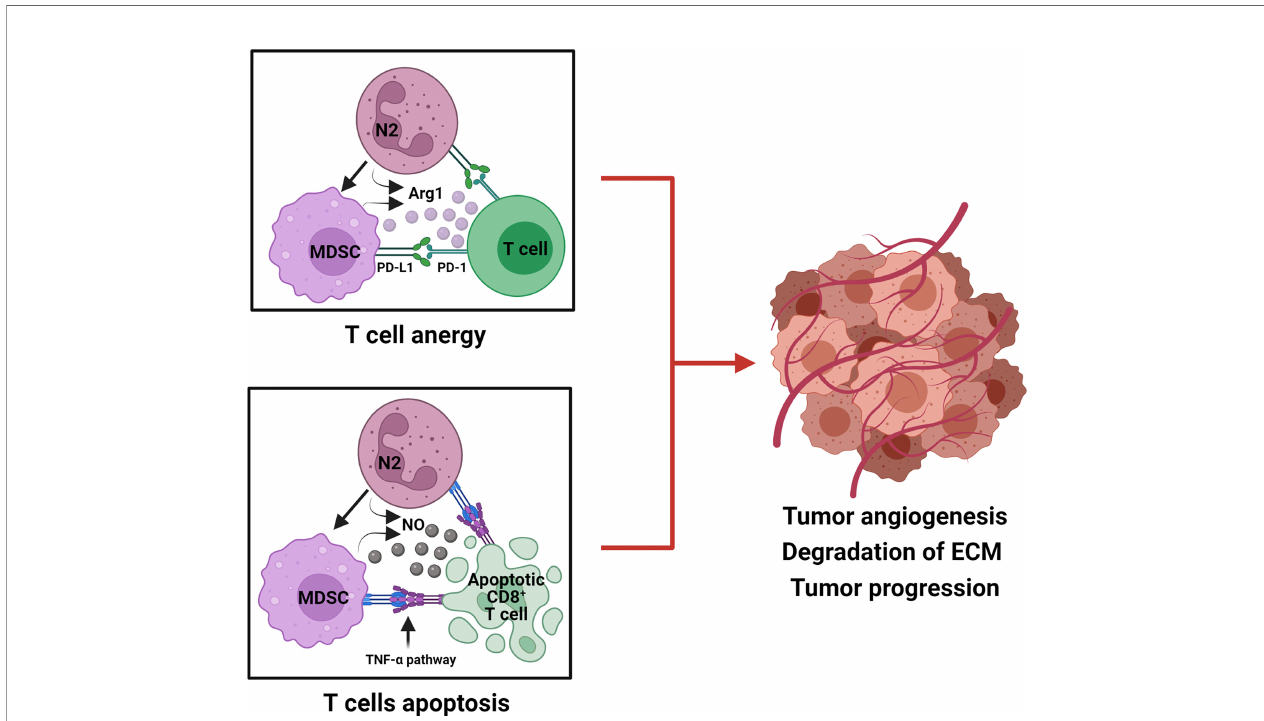
FIGURE 2 | Tumorigenic role of TANs (N2) and MDSCs in the suppression of T-cell responses. N2 TANs differentiate into MDSC, an activated and more immunosuppressive neutrophil phenotype. Both N2 and MDSC produce Arg 1 and upregulate PD-L1 to cause T-cell anergy by modulating PD-L1/PD-1 signaling. N2 and MDSC also produce nitric oxide (NO) which initiates the TNF- a pathway to induce CD8 + T-cell death, via apoptosis. N2 and MDSC hinder anti-tumor T-cell function by anergy and apoptosis and promote tumor